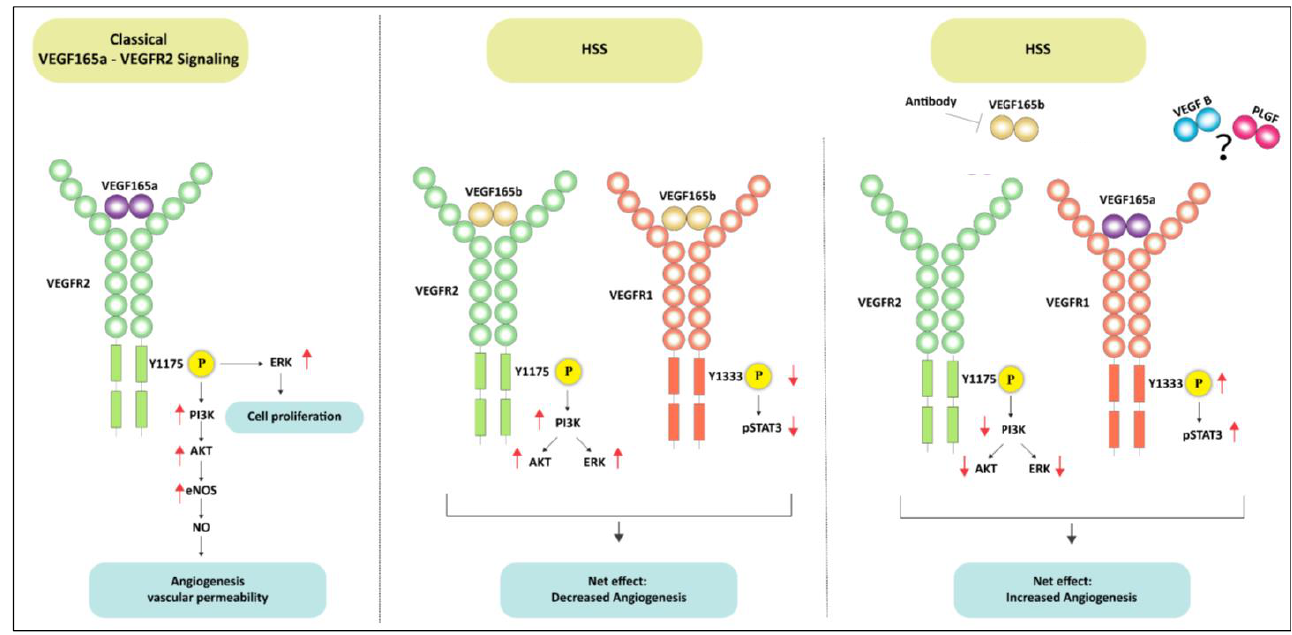
Figure 10. Schematic of VEGFR1 vs. VEGFR2 signaling activation by VEGF 165 b in ischemic endothe- lium. The left panel shows the classical VEGF 165 a induced VEGFR2 signaling pathway in ECs. The middle panel demonstrates that VEGF 165 b treatment induces VEGFR2-AKT-ERK signaling but in- hibits VEGFR1-STAT3 signaling in ischemic ECs. Despite activating VEGFR2 signaling, the inhibition of VEGFR1 signaling resulted in angiogenic inhibition in ischemic ECs treated with VEGF 165 b. In the right panel, antibody-mediated VEGF 165 b inhibition increased the bioavailability of VEGF 165 a to VEGFR1 (due to its 10X higher binding affinity to VEGFR1 over VEGFR2) and activated VEGFR1- STAT3 signaling but resulted in the loss of VEGFR2 signaling activation. Activating VEGFR1-STAT3 signaling-induced ischemic angiogenesis independent of VEGFR2 signaling.